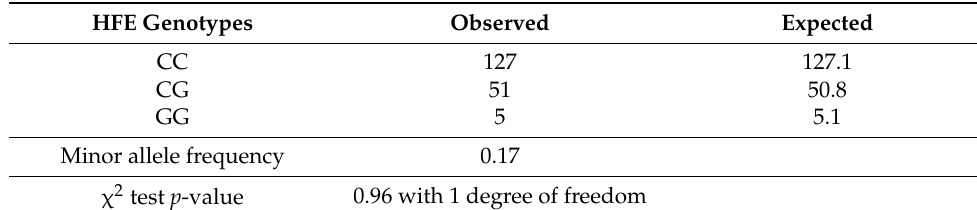
Table 3. Calculation of Hardy–Weinberg equilibrium for HFE genotypes.